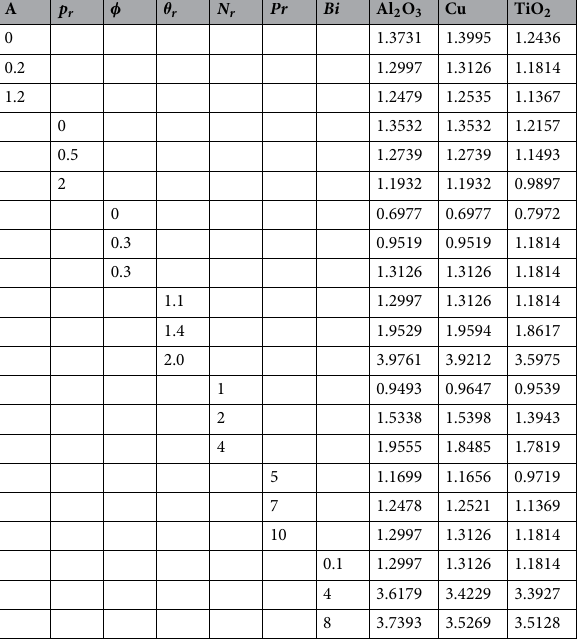
Table 4. Disparity of the Nusselt number for numerous values of water-base